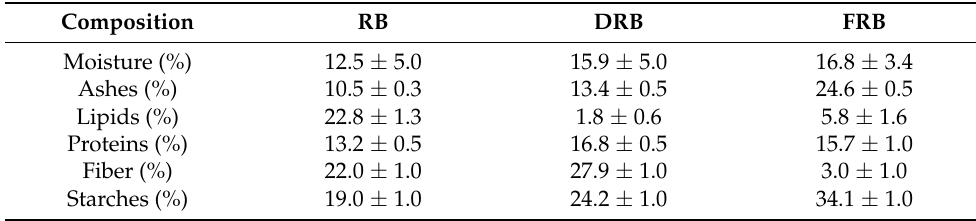
Table 1. Chemical composition of the different active matters employed: rice bran (RB), defatted rice bran (DRB) and fiber-free rice bran